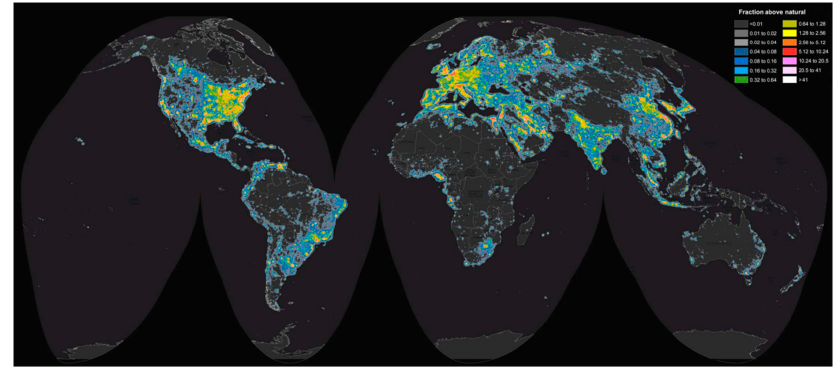
Figure 3. World map of artificial sky brightness. The map shows, in twofold increasing steps, the artificial sky brightness as a ratio to the natural sky brightness (assumed to be 174 μ cd/m 2 ). The colors represent the amount of artificial brightness with warmer colors indicating higher levels of artificial brightness. For details on the study, please see the manuscript: Falchi et al. (2016), the new world atlas of artificial night sky brightness [2]. Reprinted from Science Advances , Falchi et al. (2016). The Authors, some rights reserved; exclusive licensee American Association for the Advacement of Science. Distributed under a Creative Commons Attribution NonCommercial License 4.0 (CC BY-NC) http://creativecommons.org/licenses/by-nc/4.0/.